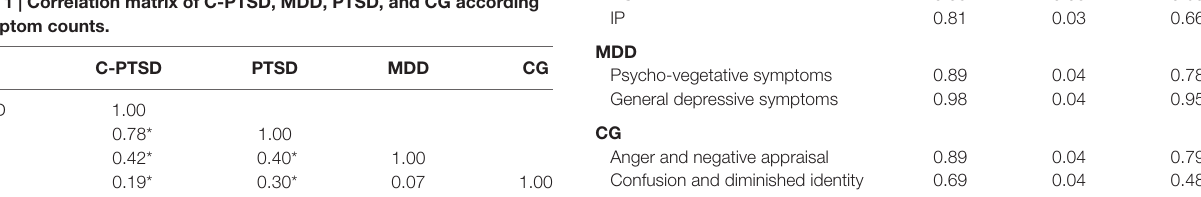
constructs based on the sum of their total symptom